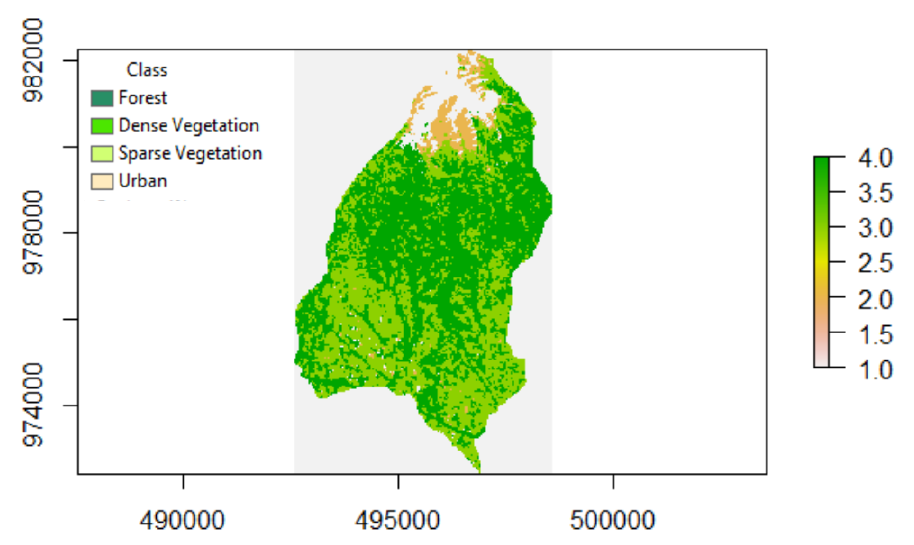
Figure 7. The NDVI values to label the land cover.